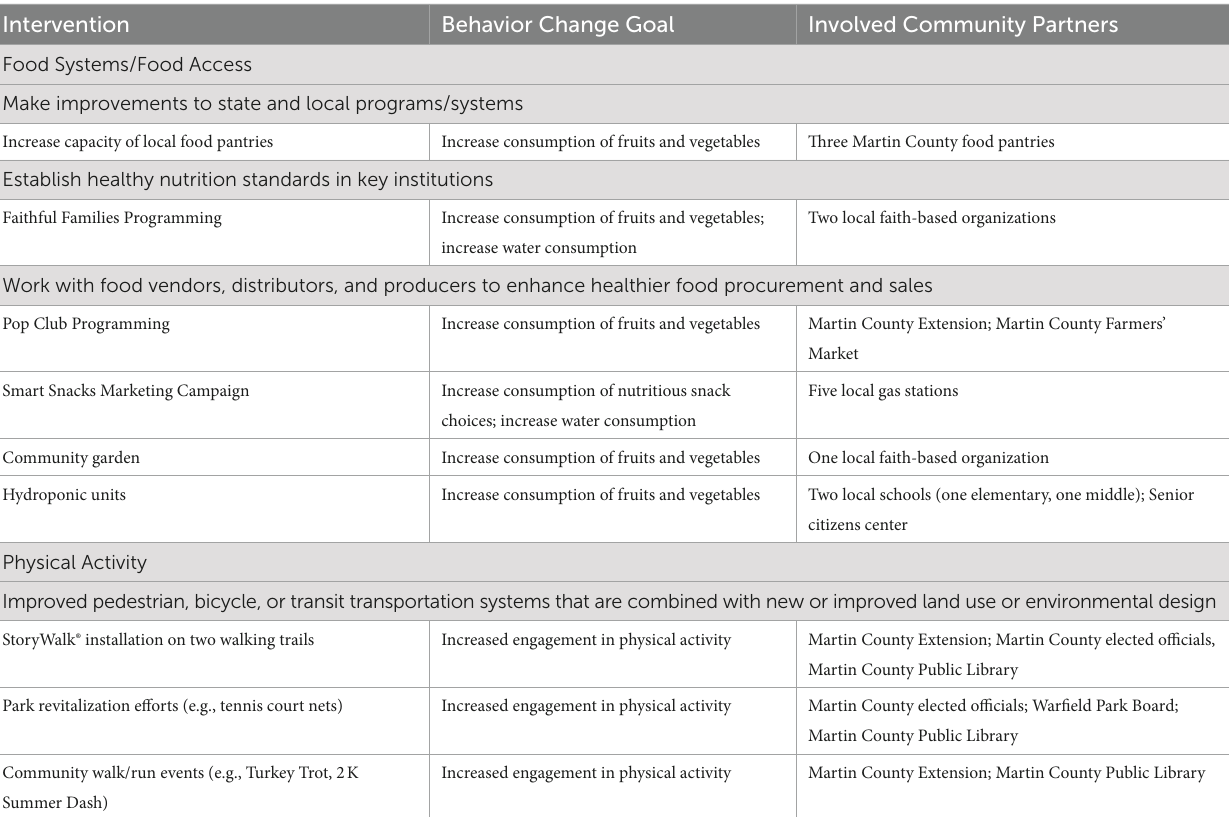
TABLE 1 Community-based interventions implemented within the specified county during the study period (2019–2022).